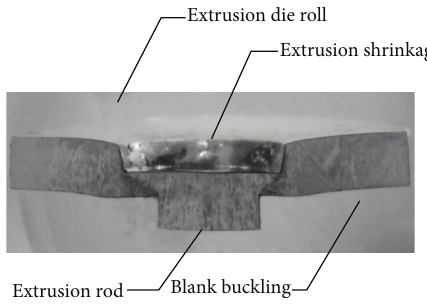
Figure 4: Cross section part of SME configuration.